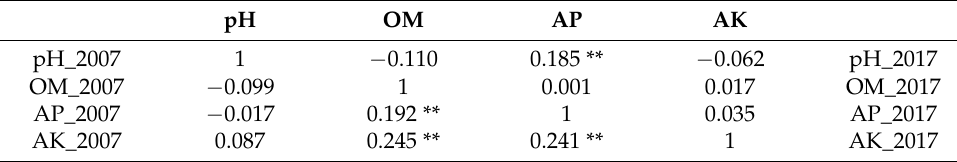
Table 4. The relationships among soil properties in Hefeng in 2007 and